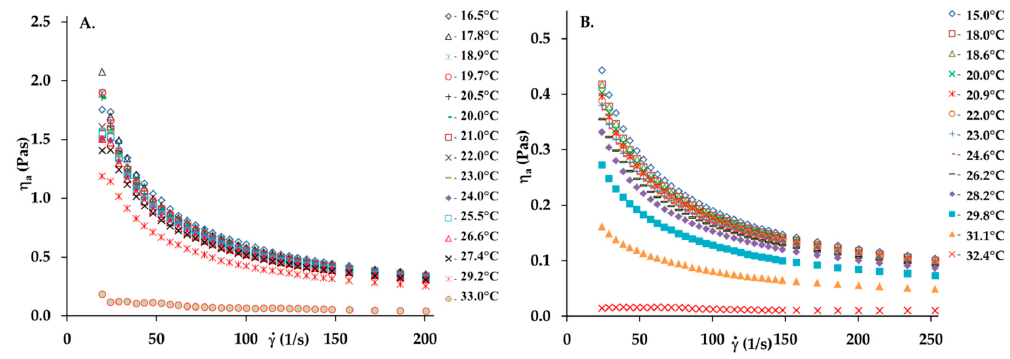
Figure 1. Viscosity curves of the collagen solutions: ( A ) 10mg/mL, ( B ) 5 mg/mL in temperature range 15 to 33 °C.